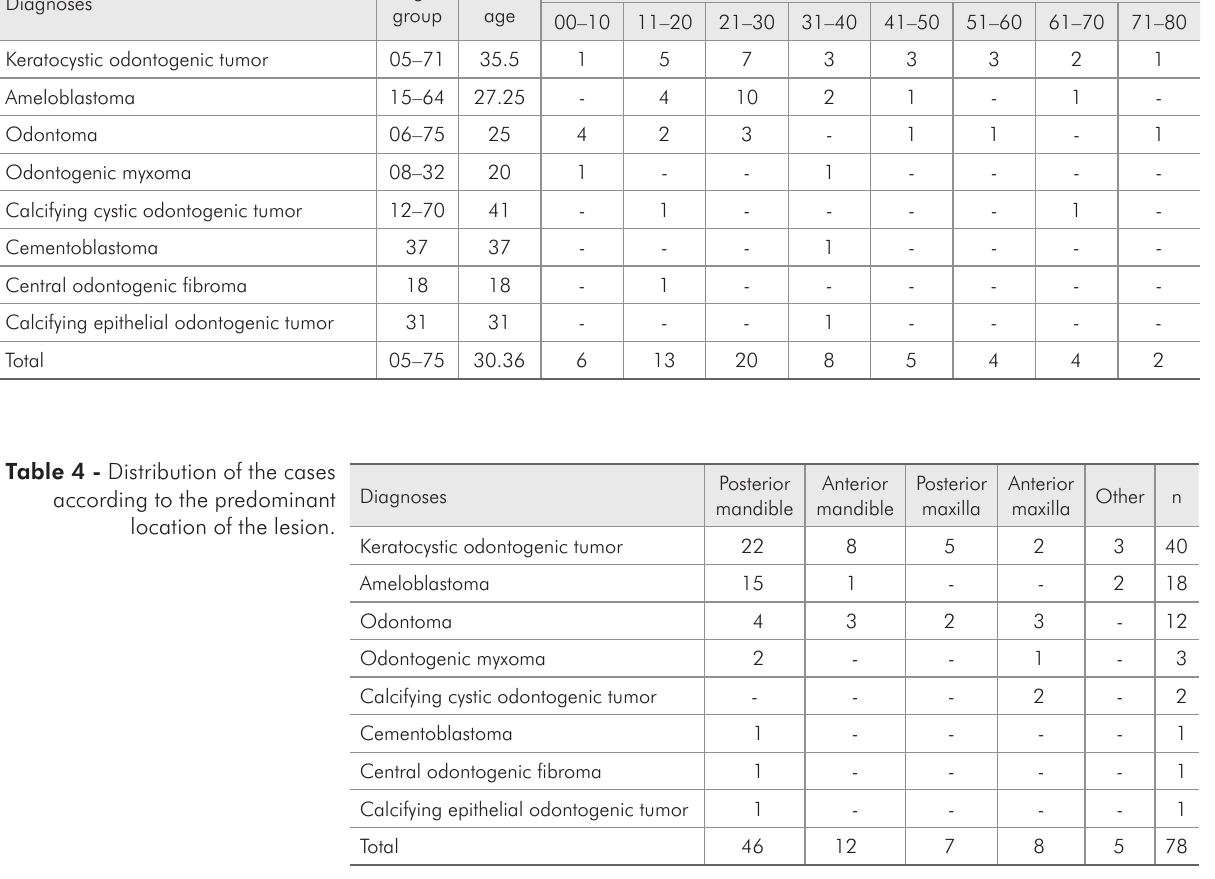
Table 3 - Distribution according to the patients’ age group. Diagnoses